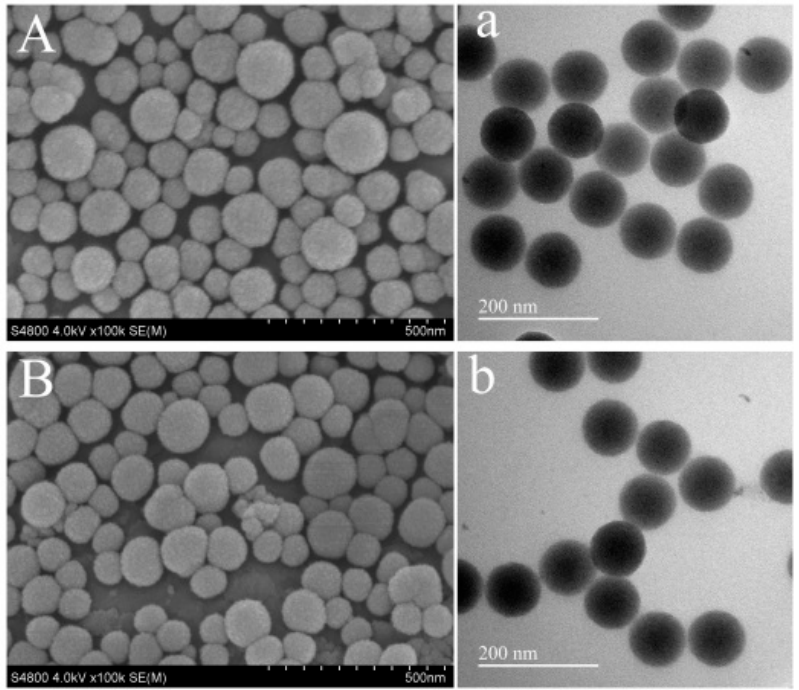
Figure 1. SEM images: ( A ) MIP-QDs and ( B ) NIP-QDs. TEM images: ( a ) MIP-QDs and ( b ) NIP-QDs.